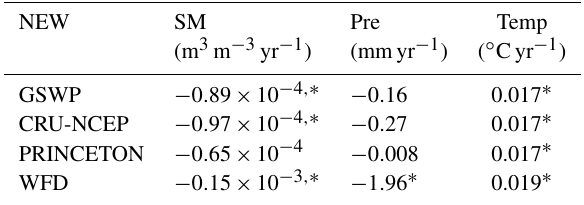
Table 3. Trends in NEW-simulated surface soil moisture, precipita- tion, and temperature forcing data. ∗ = p < 0 .